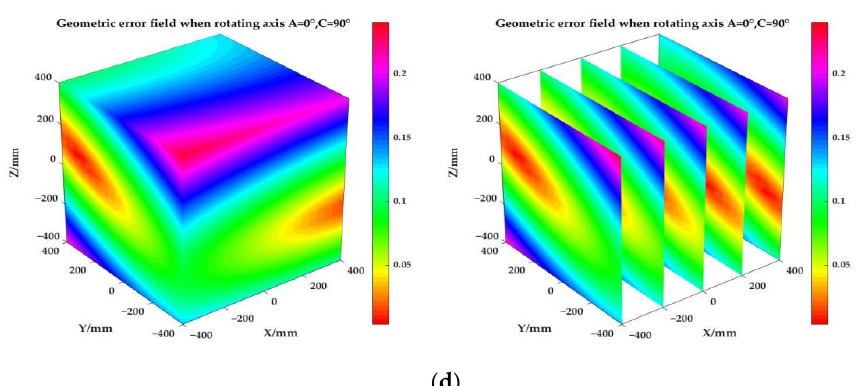
Figure 12. The distribution of the comprehensive error field at all angles of the C-axis at 0 ◦ A axis for